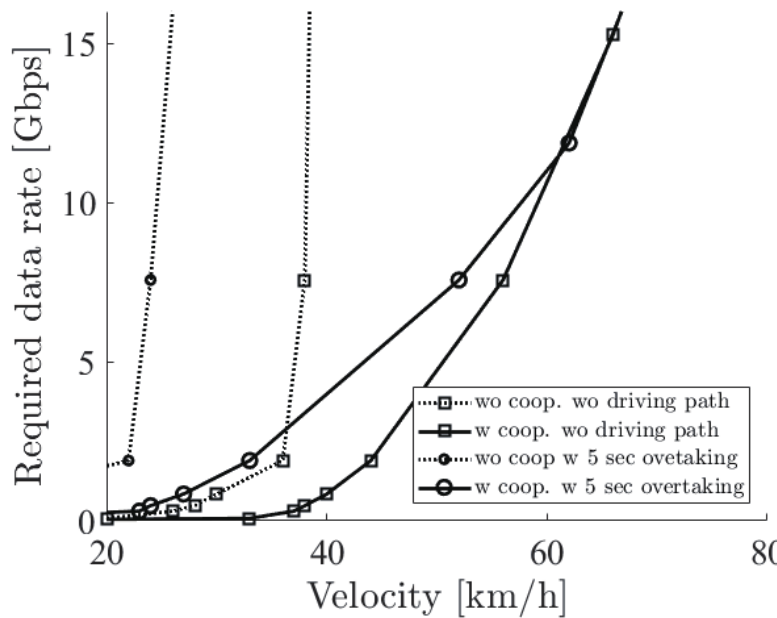
Figure 10. The required sensor data rate with the options of cooperative perception and the driving path when the distance between the ego vehicle and the blocking vehicle is 5